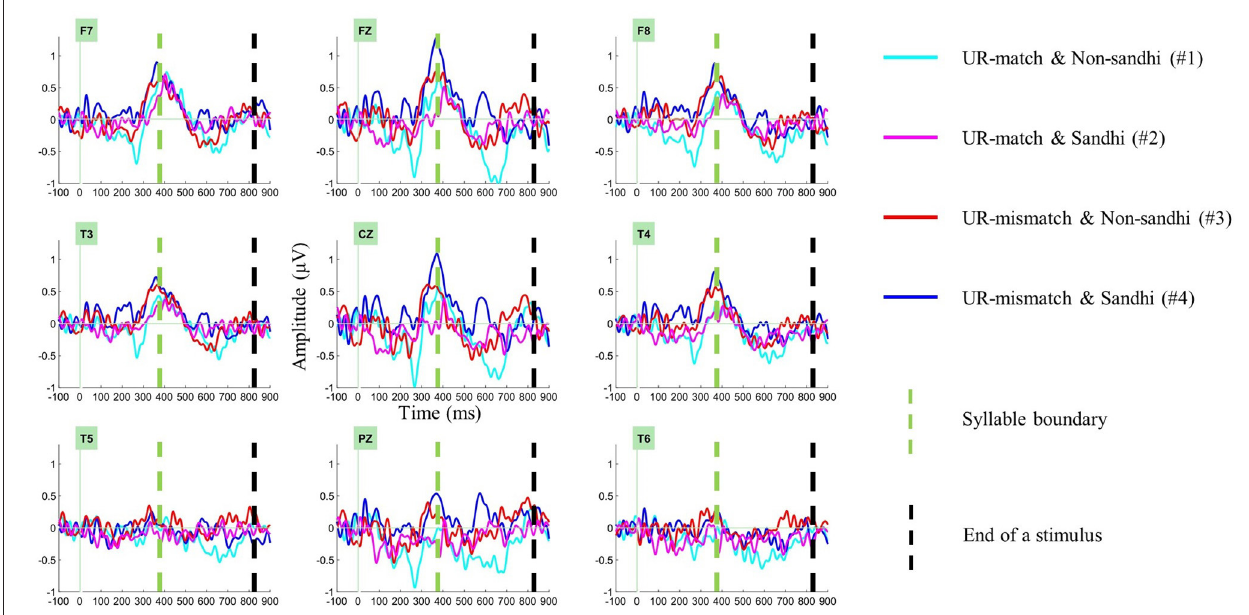
FIGURE 5 | Identity difference waves (deviant minus standard) for all conditions over selected electrodes. The waveforms at the syllable boundary are either positive-going or positive, followed by negative-going waves in the second syllable (S2), suggesting that the S2 negativity cannot be explained by spill-over effects from the first syllable